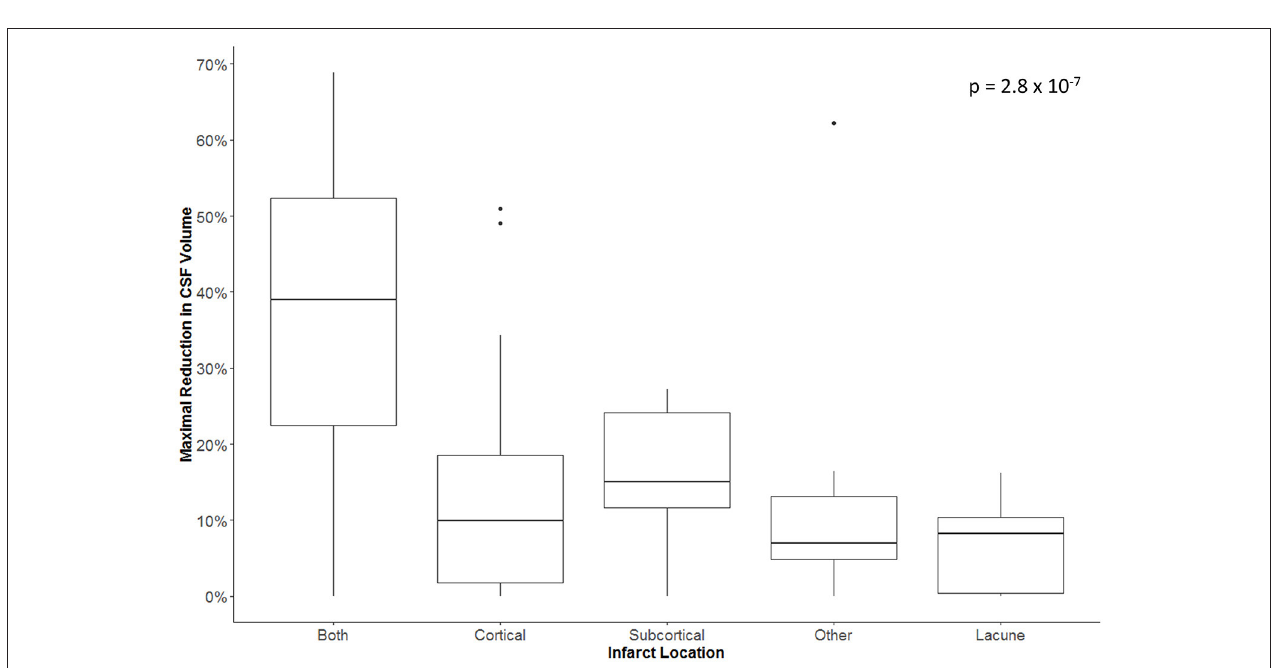
FIGURE 6 | Relationship between infarct volume (based on largest hypodensity measured from available head CT scans) and maximal reduction in CSF volume.